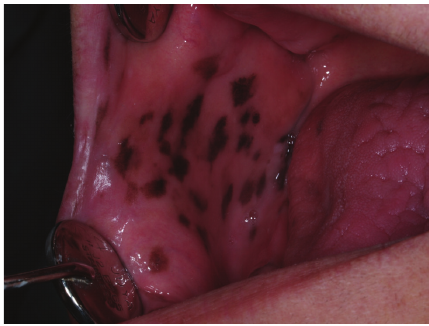
Figure 1: Mucocutaneous pigmentation on the buccal mucosa.